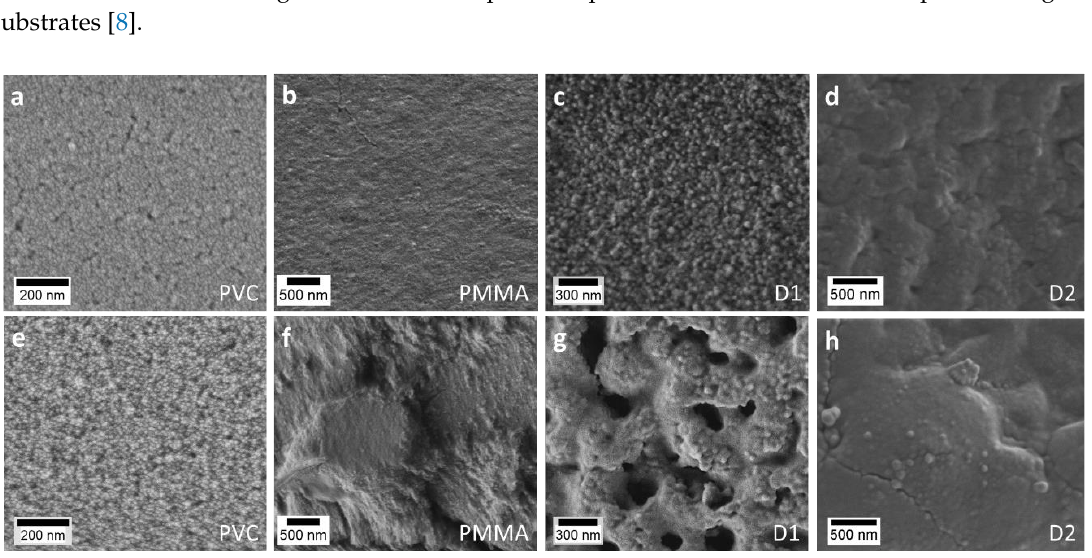
Figure 6. Mechanical stability measured by hardness pencil test. Surface properties were evaluated by measuring water contact angles (WCA) and they are shown in Figure 7 . The WCAs of bare substrates were approximately 85° except for PMMA (65°) and D1 (95°); the hig h WCA of the latter is the consequence of the presence of fluorine in the PVDF top layer, which is not present in the D2 neat substrate. The WCAs of all bare substrates do not show significant change after 3h of UV irradiation. On the other hand, coating the surfaces with TiO 2 films showed much lower initial WCAs in PVC_s (15 –25°) and PMMA (15–20°) substrates; it did not, however, affect the D1 and D2 initial WCAs — they remained relatively high, i.e., 70° and 80° for D2 and D1 substrate, respectively. Upon irradiation, the WCAs decreased in PVC_s and PMMA